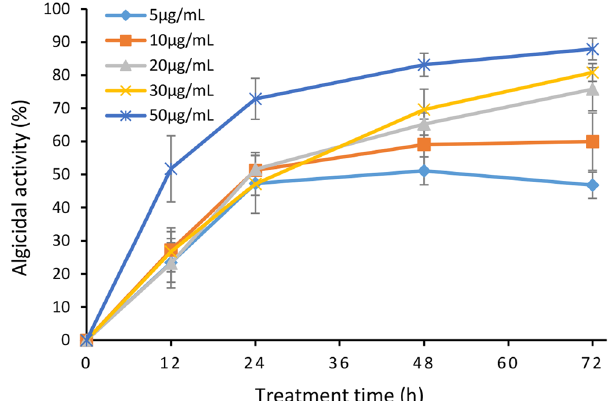
Figure 1. Algicidal activity of PG against M. aeruginosa at concentrations of 5, 10, 20, 30 and 50 μ g/mL. The algicidal activity was detected at 12, 24, 48 and 72 h. All data are means ± SD (n = 3).